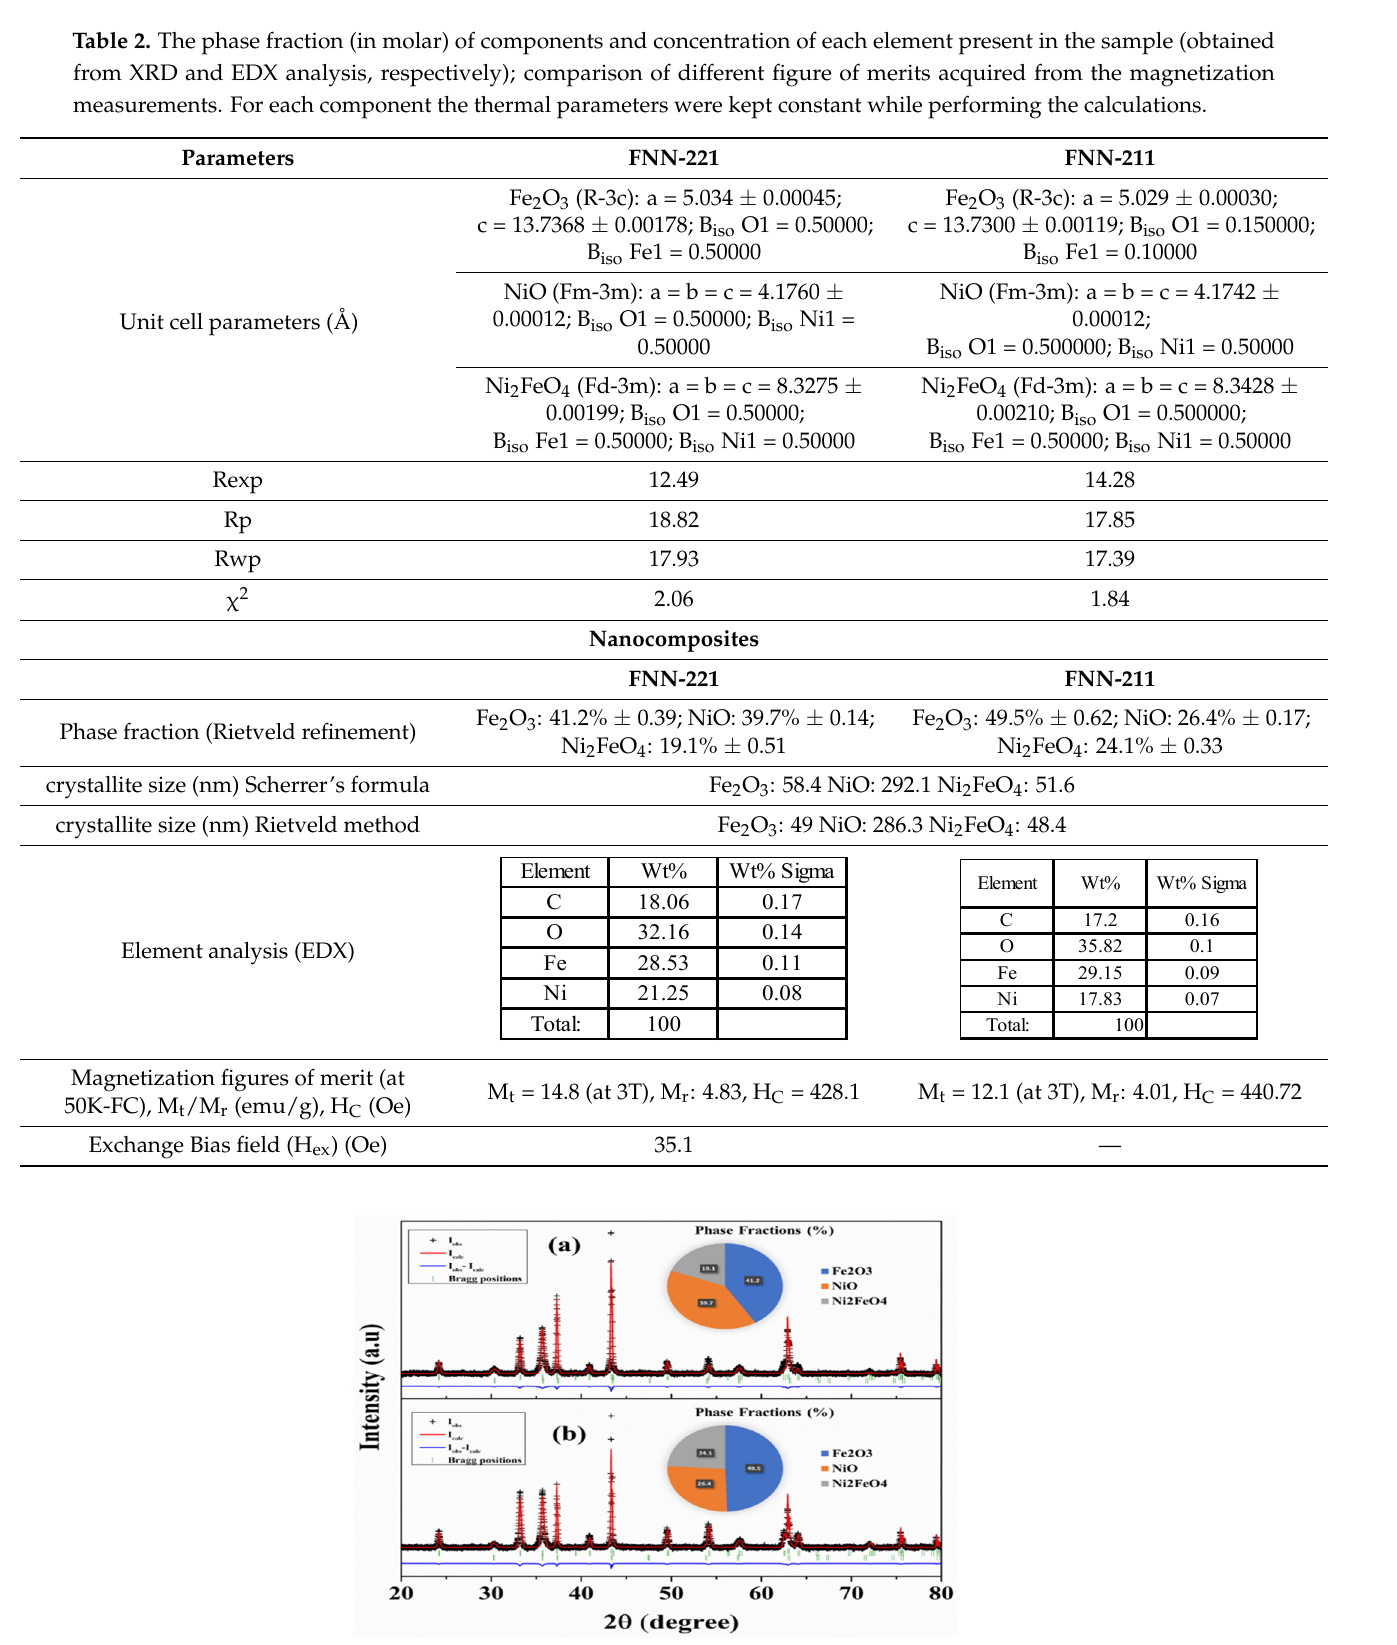
Figure 1. ( a , b ) XRD profiles of FNN-221 and FNN-211 sample, respectively, phase fraction chart has been obtained through the Rietveld method in HighScore plus.